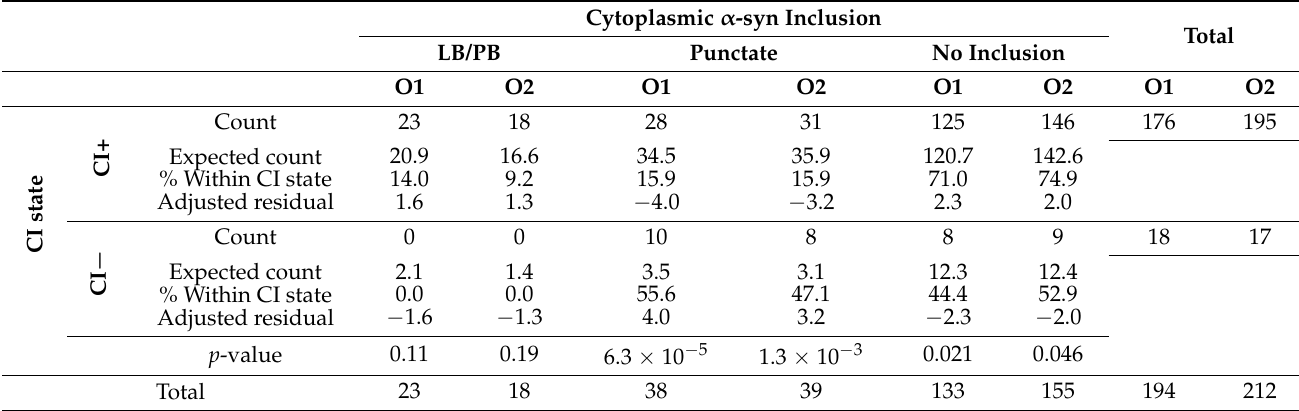
Table 2. A 2 × 3 contingency table of CI state (negative/positive) by α -syn inclusion (LB or PB/punctate inclusions/no inclusion).